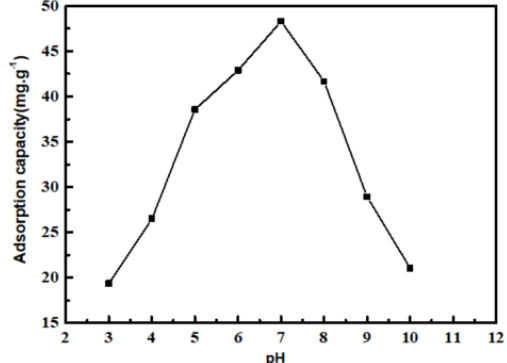
Figure 10. The effect of the pH value on the adsorption capacity. Figure 10. The e ff ect of the pH value on the adsorption